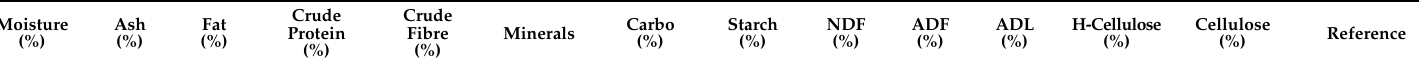
Table 2. Chemical composition (% DM) of discussed diets used for house cricket